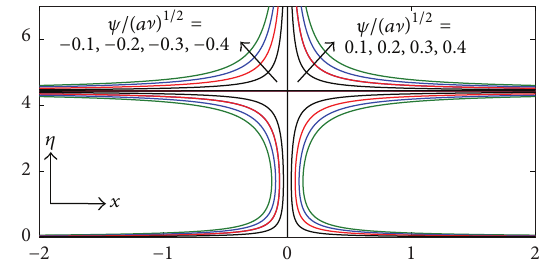
Figure 2: Variation of streamlines for 𝑠 = −3 , Pr = 3 , 𝑀 = 0.2 , 𝛾 = 0.5